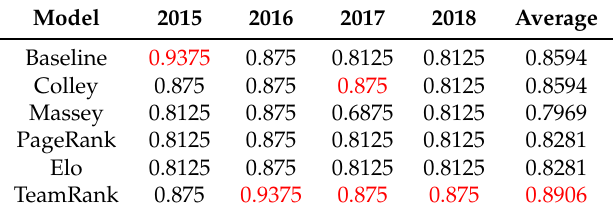
Table 5. Playoff accuracy of the results. Red values indicate the highest playoff accuracy for each season.